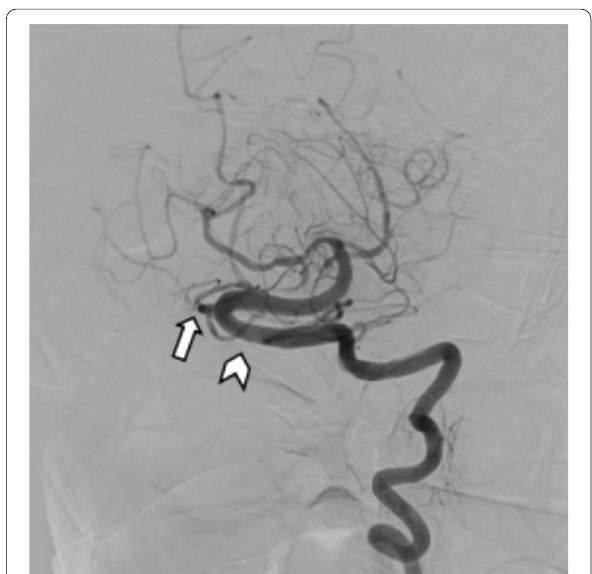
Fig. 3 Tortuosity vertebrobasilar artery (bow) and AICA